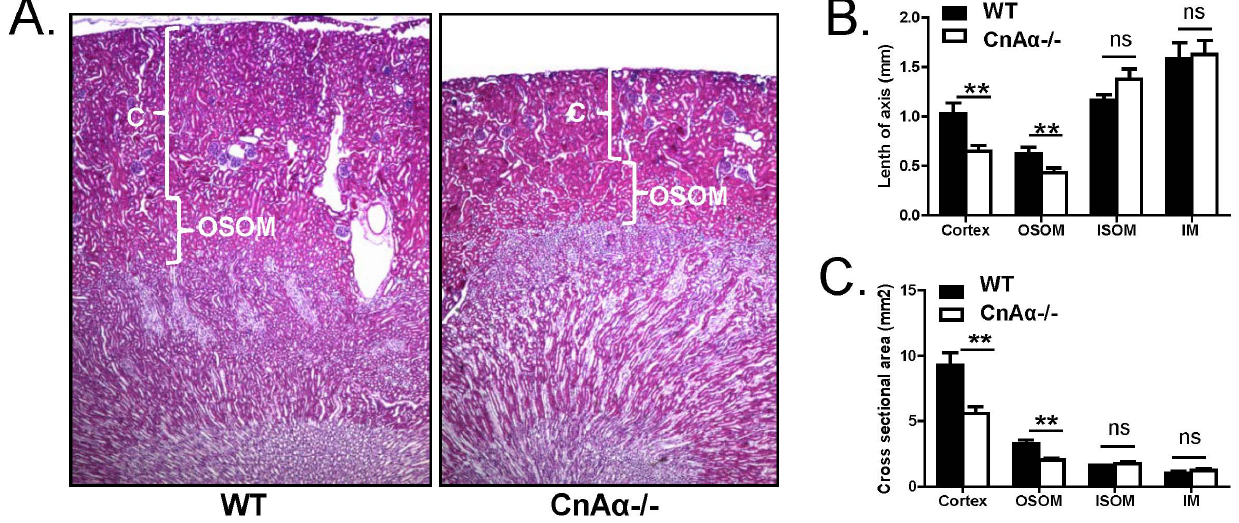
Figure 2. Measurement of kidney regions in CnA a 2 / 2 and WT kidneys. A) Representative H&E staining of perfusion fixed kidney sections from WT and CnA a 2 / 2 mice. Original magnification was 10x. B) Quantitation of axonal length measured as a perpendicular line from the tip of the papilla to the cortical surface. Results from WT (N=5) and CnA a 2 / 2 (N=6) mice are shown. **p , 0.01 compared to WT. C) Quantitation of cross sectional area of cortex, OSOM, ISOM and IM in WT (N=5) and CnA a 2 / 2 (N=6) mice. ** p , 0.01 compared to